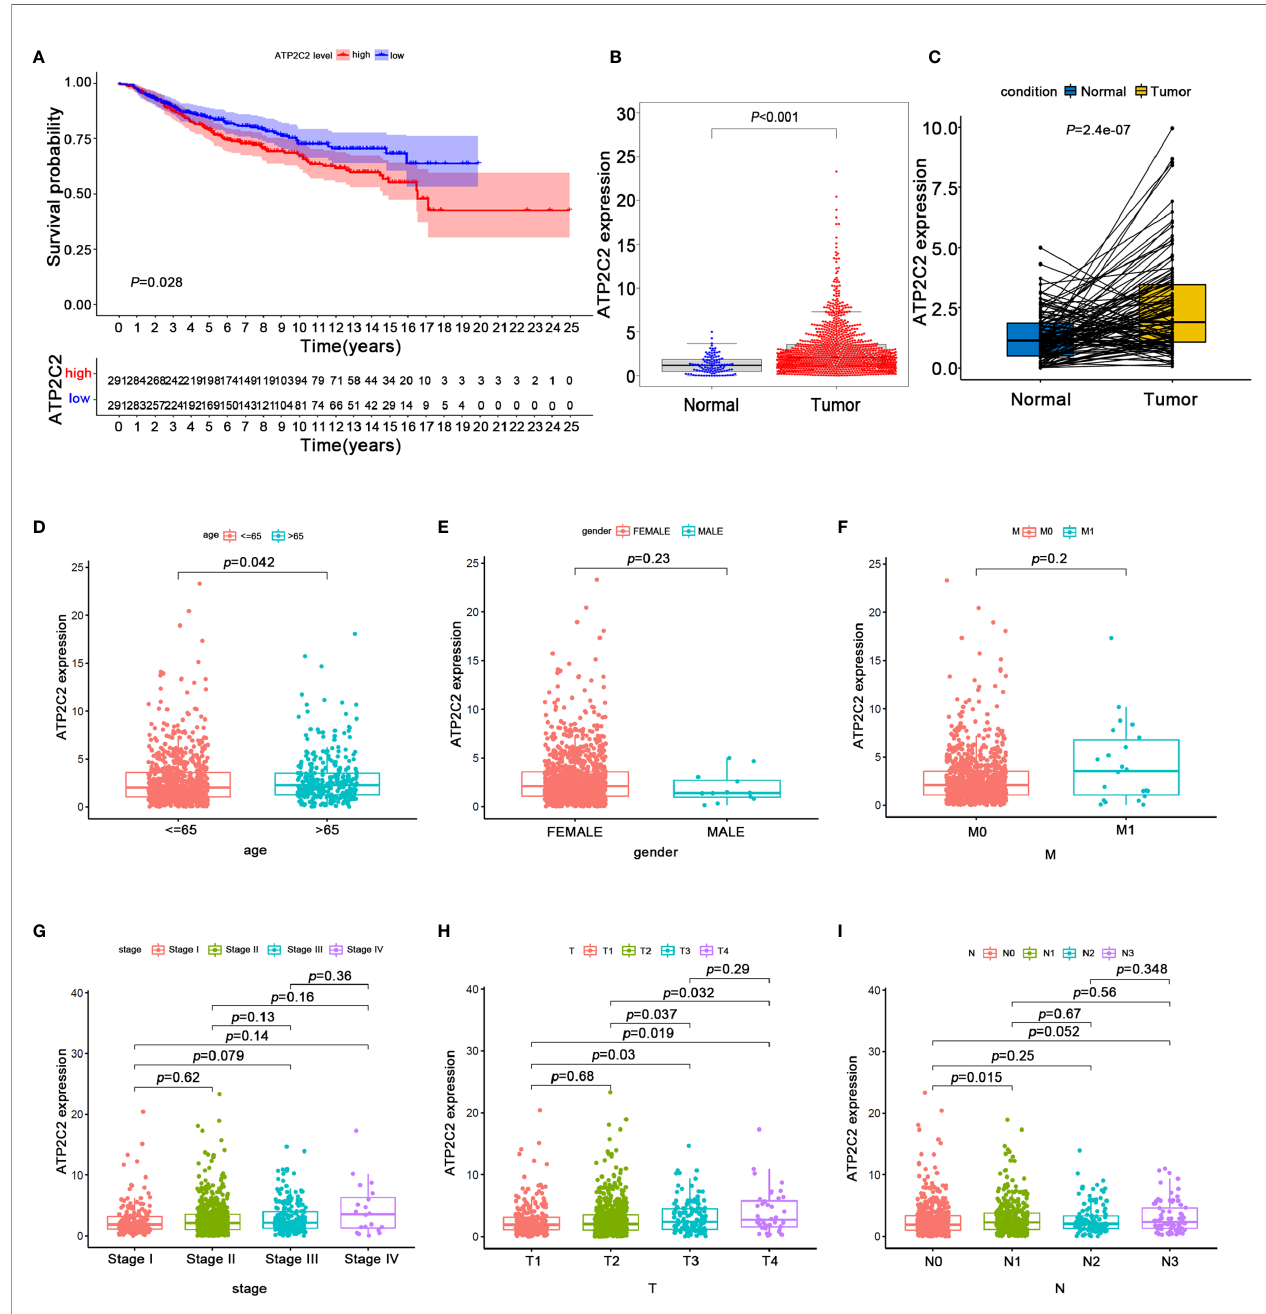
FIGURE 5 | The expression of ATP2C2 and correlation with OS and clinicopathological features of BRCA patients revealed by bioinformatic analysis. (A) Survival outcome for BRCA patients with different ATP2C2 expression. The differences between the two curves were detected by the two-side log-rank test. (B) ATP2C2 mRNA is highly expressed in BRCA tissues. Statistical signi fi cance was evaluated using Wilcoxon-Mann-Whitney test. (C) ATP2C2 mRNA levels in the paired BRCA tissues were evaluated. P -values are based on the Wilcoxon Test. (D – I) The correlation of ATP2C2 expression with clinicopathological features. Statistical signi fi cance was evaluated using Wilcoxon rank sum